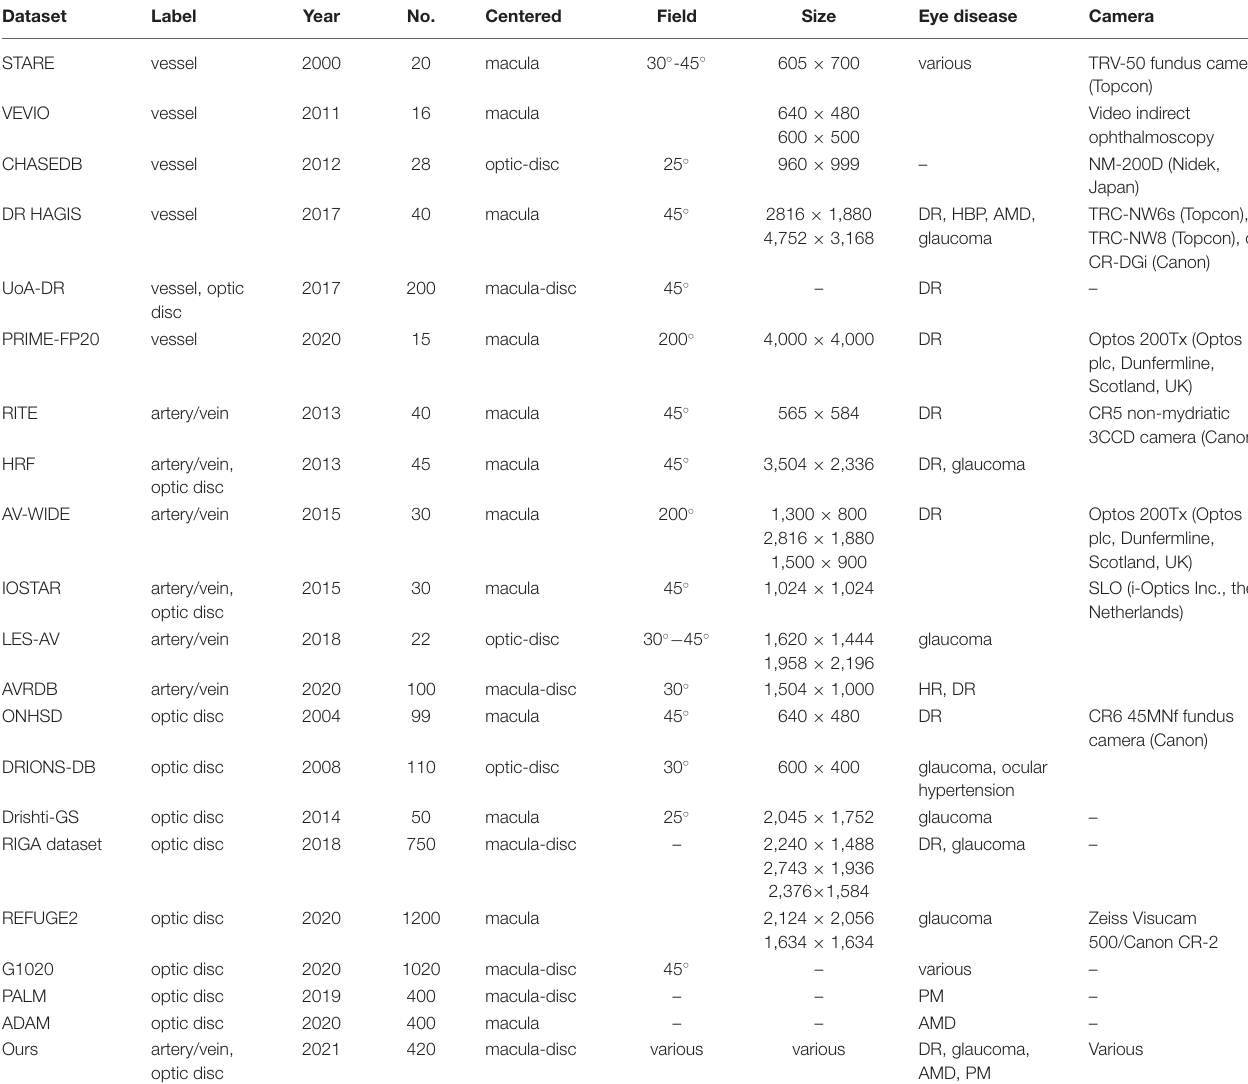
TABLE 2 | Characteristics of the 21 datasets used to develop the segmentation algorithm. Only images with available labels were included. AMD, age-related macular degeneration; HR, hypertensive retinopathy; PM, pathologic myopia; DR, diabetic retinopathy.